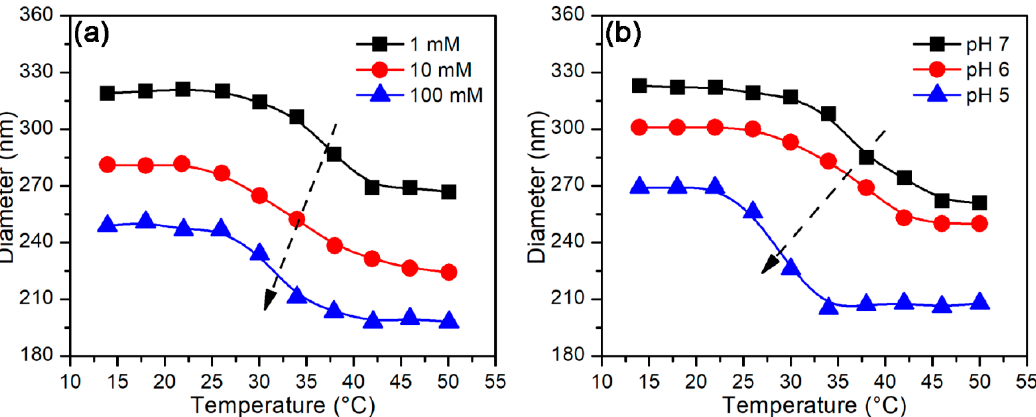
Figure 3. Effect of temperature on hydrodynamic diameters of PSV@PNIPA- b -PAA ( a ) in different ionic strength at pH of 7.4 and ( b ) at different pHs in 1 mM PBS.